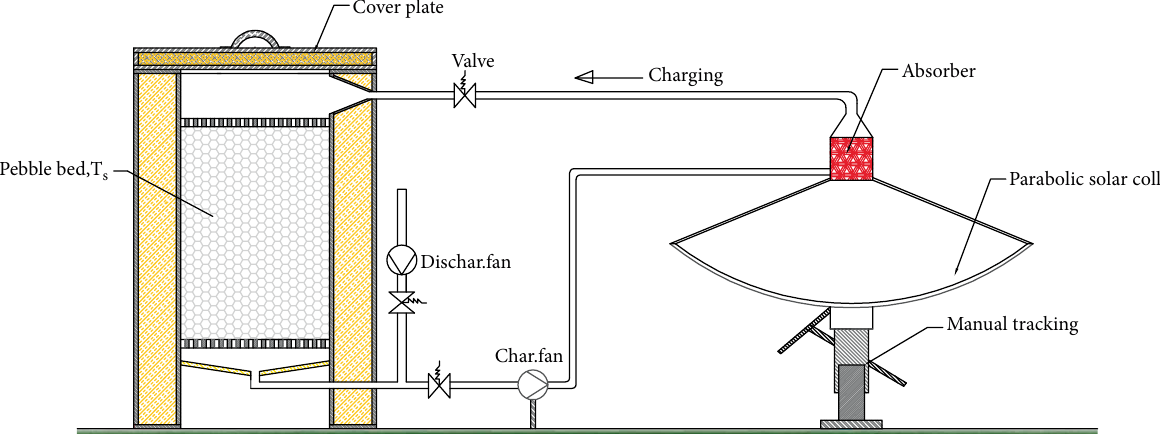
Figure 1: Schematic diagram of pebble bed thermal storage integrated with parabolic solar collector and